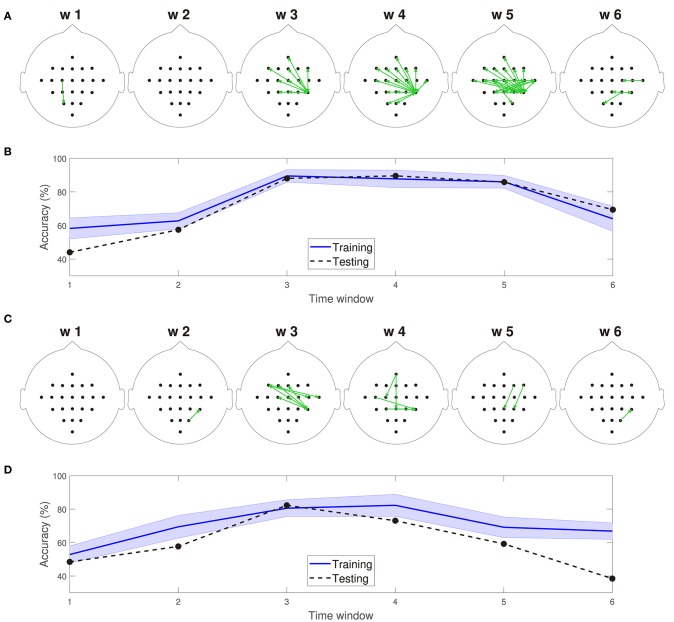
(A) Connections with statistically significant differences between the MI tasks for time windows 1–6 for subject 8. (B) Training and testing classification accuracies per time window for subject 8. (C) Connections with statistically significant differences between the MI tasks for time windows 1–6 for subject 9. (D) Training and testing classification accuracies per time window for subject 9. For visualization purposes, only 10% of the statistically significant connections, those with the smallest p-values, are depicted in (A,C).